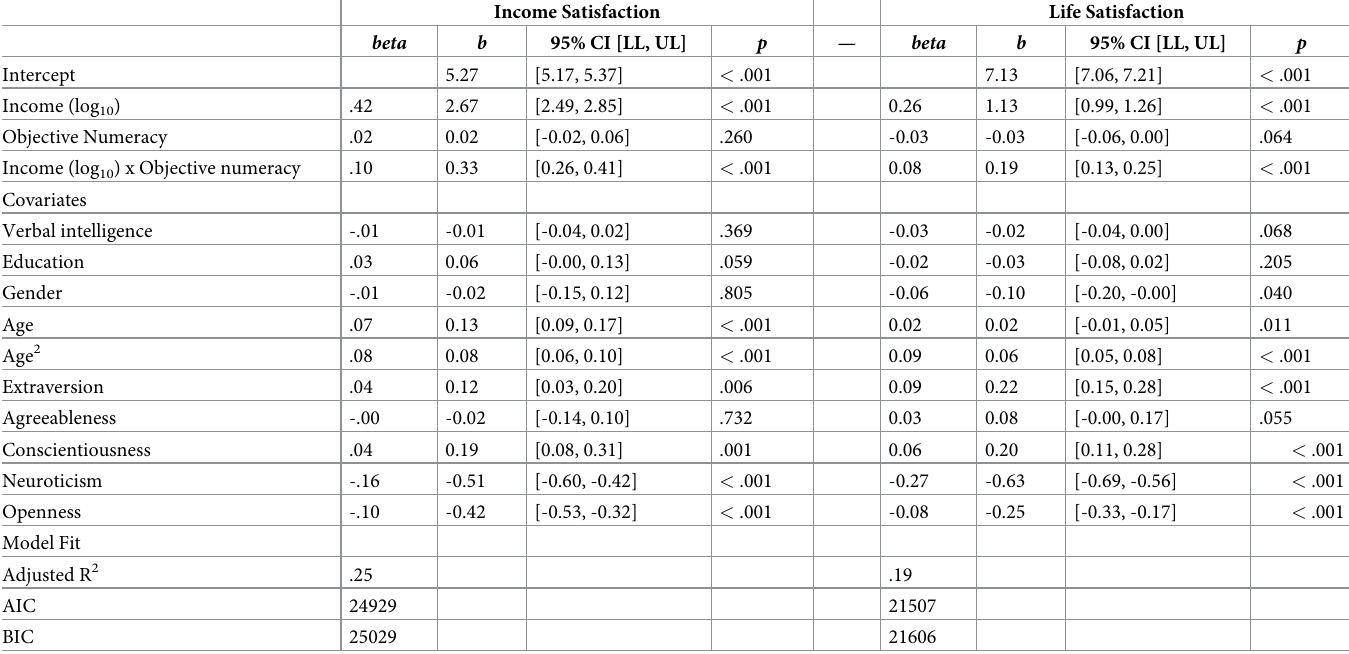
Table 3. Linear regression analysis results of income satisfaction and life satisfaction predicted from income, objective numeracy, their interaction, verbal intelli- gence, education, gender, age, age 2 , and Big-Five personality